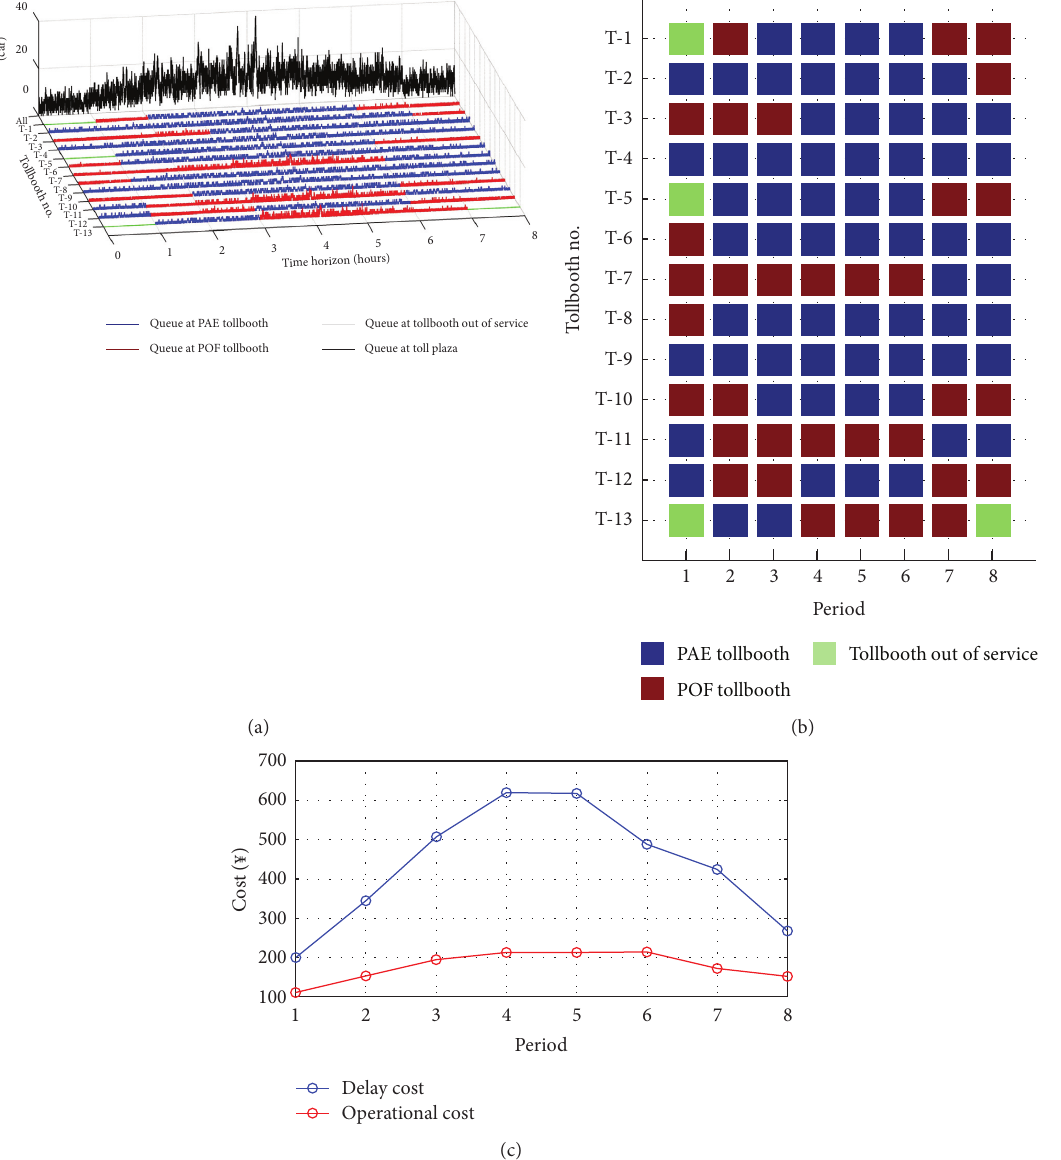
Figure 16: Recommended tollbooth operation scheme and its performance with weight of operational cost � 0.5. (a) Queue length evolution with time. (b) Best tollbooth operation scheme. (c) Costs in each